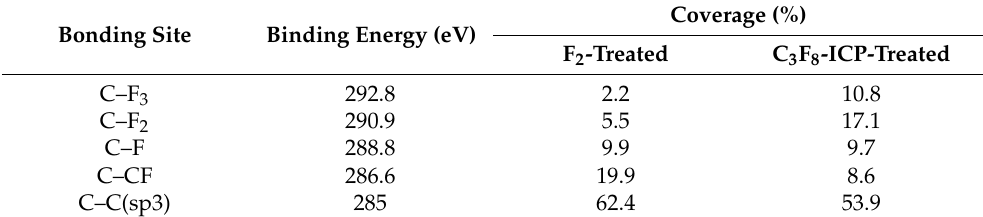
Figure 3. X-ray photoelectron spectra of the C–F diamond surfaces: ( A ) a narrow scan of C 1s of the C–F diamonds fabricated via fluorine gas treatment and ( B ) a narrow scan of C 1s of the C–F dia-